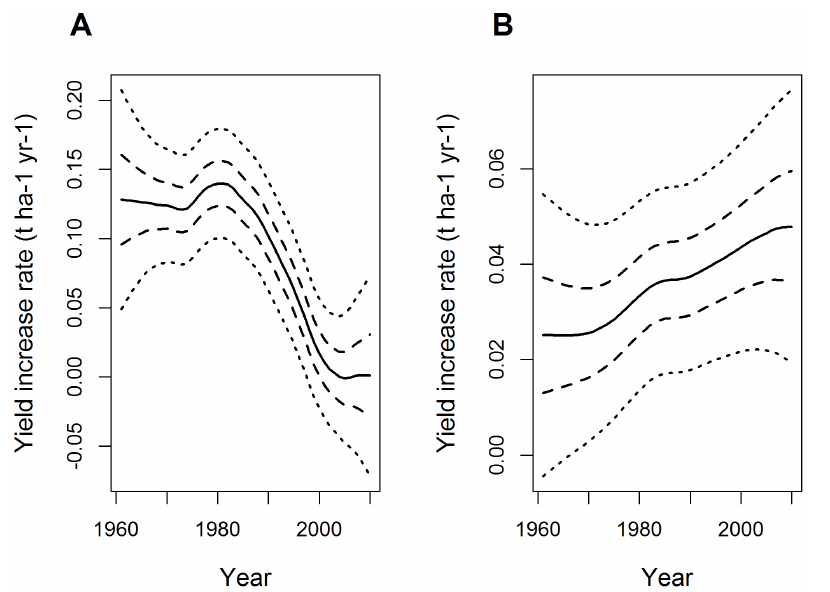
Figure 5. Estimated yield increase rates obtained with DLMs for wheat from 1960 to 2010 (continuous line), first and third quartiles (dashed lines), and 95% confidence intervals (dotted lines). A: France. B: